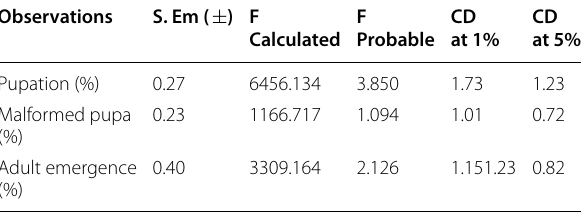
S. Em standard error of mean; CD critical difference